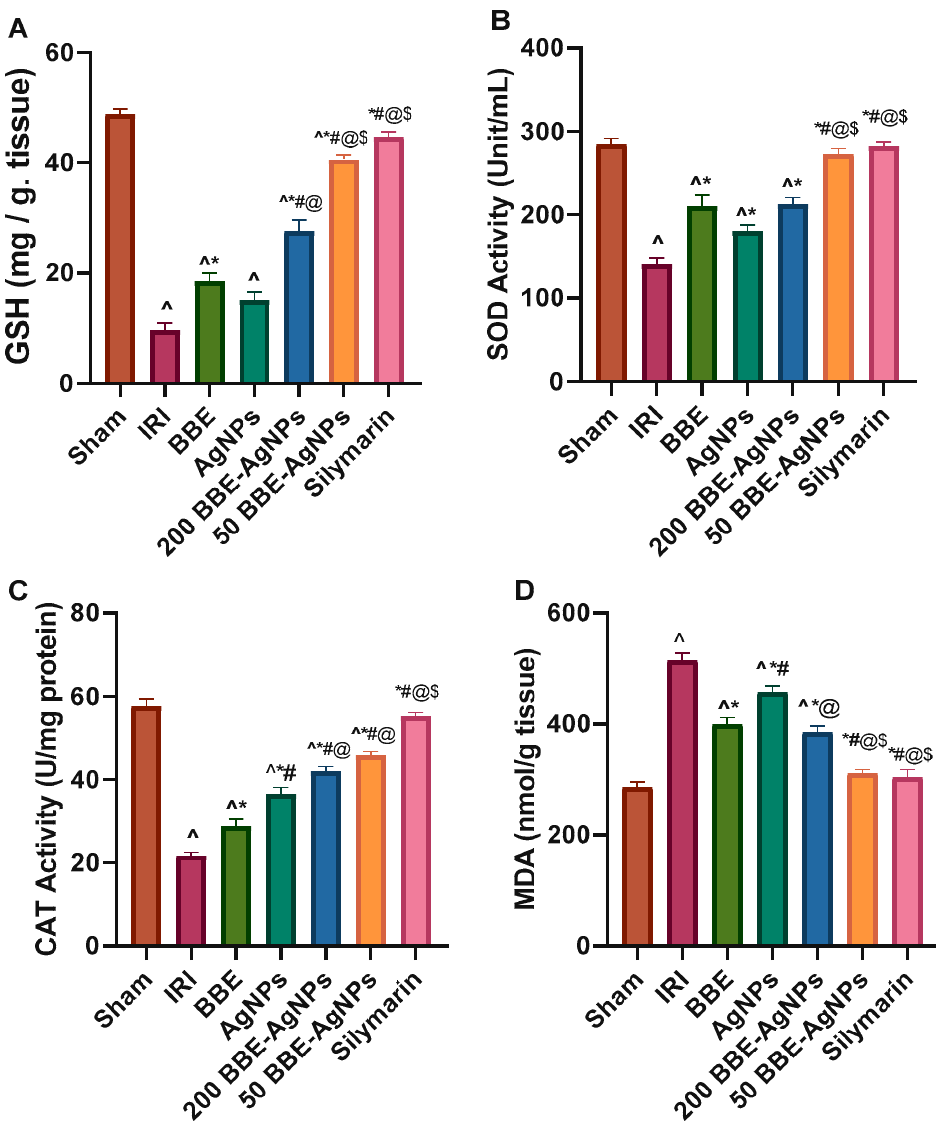
Figure 5. Effect of pretreatment with BBE , AgNPs, 200 or 50 BBE -AgNPs and Silymarin on hepatic content of ( A ) GSH, ( B ) SOD, ( C ) CAT and ( D ) MDA level in hepatic I/R injured rats. Values are presented as means of 6 animals ± SEM. Data were analyzed using one-way ANOVA followed by Tukey’s Multiple Comparisons Test; p < 0.05. As compared with (ˆ) Sham, (*) IRI, (#) BBE , (@) AgNPs and ($) 200 BBE -AgNPs. ANOVA, analysis of variance; GSH, reduced glutathione; CAT, catalase; SOD, superoxide dismutase; MDA, malondialdehyde; BBE , Blackberry Extract; IRI, ischemia/reperfusion injury; AgNPs, Silver Nanoparticles; BBE -AgNPs, Blackberry loaded Silver